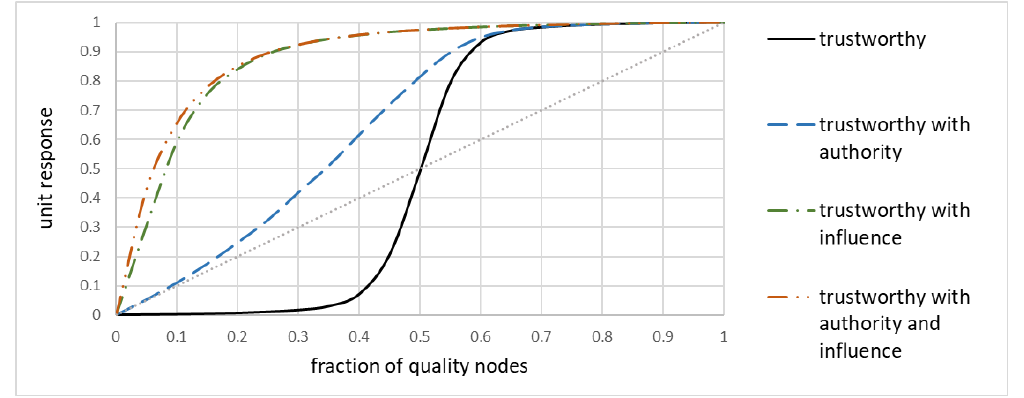
Figure 8. Unit response for various additional properties.